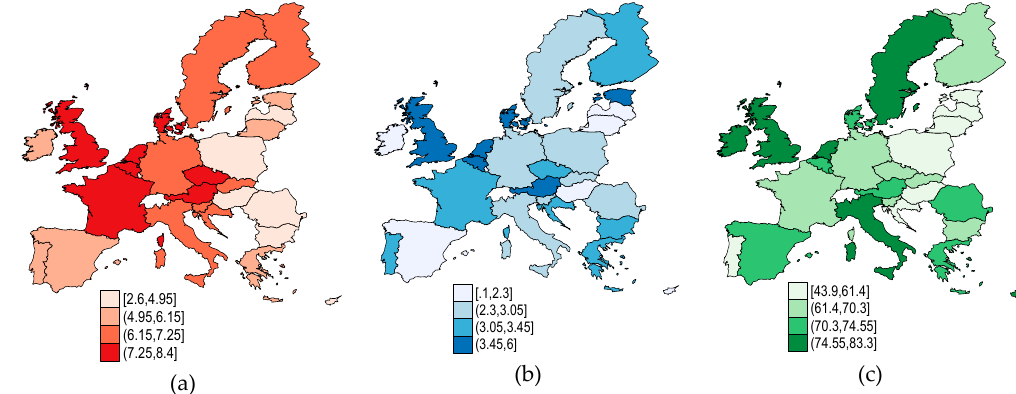
Figure 2. Health illustrative indicators, EU-28, 2017: ( a ) Health government expenditure (HGE) ; ( b ) hospital services (HS) ; ( c ) people (aged 16+) with good or very good perceived health (PGPH) . Source: Own process in Stata.